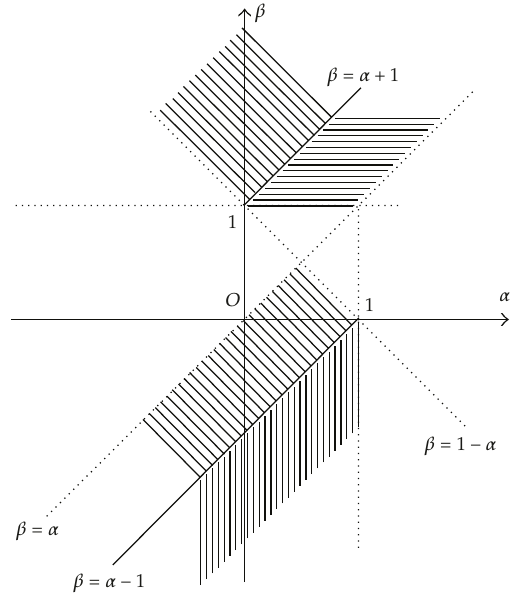
Figure 6: (cid:3) α,β (cid:5) -domain where q α,β (cid:3) t (cid:5) is decreasing on (cid:3) −∞ , 0 (cid:5)